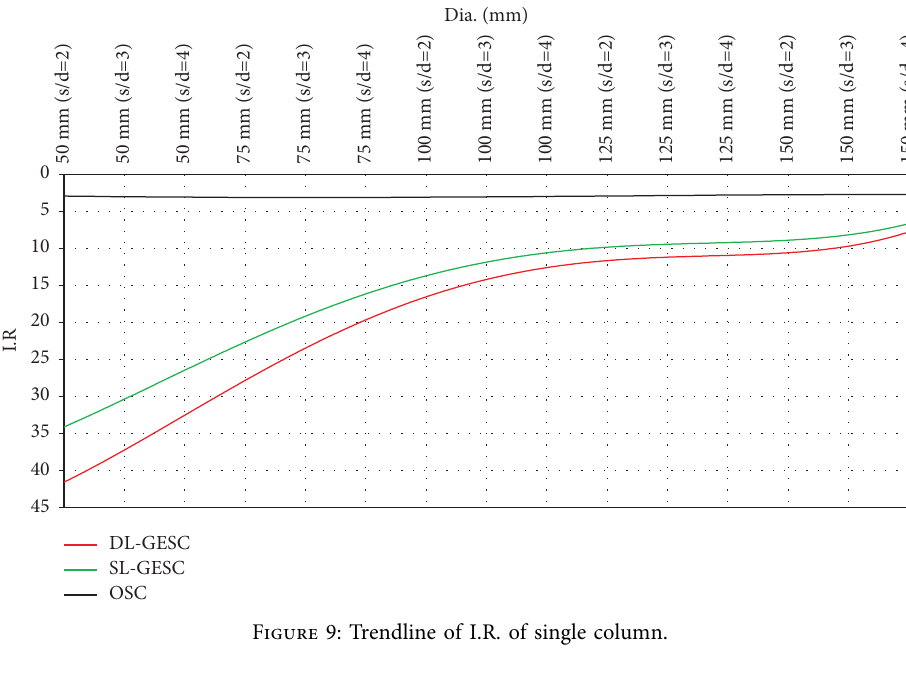
Figure 9: Trendline of I.R. of single column.